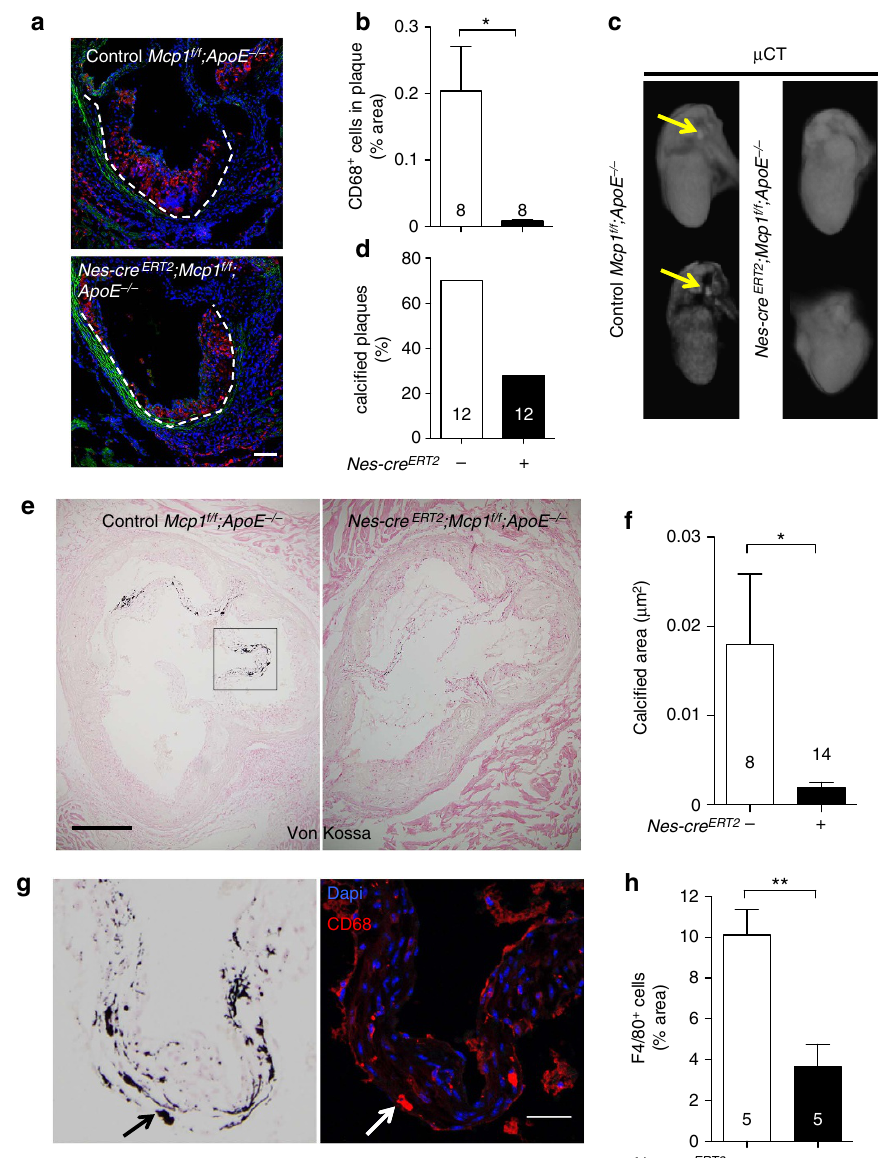
Figure 6 | Mcp1 deletion in nestin þ cells reduces vascular calcification. ( a ) Immunofluorescence of CD68 (red) to label macrophages infiltrated in the valves of Nes-cre ERT2 ;Mcp1 f/f ; ApoE (cid:2) / (cid:2) mice and Mcp1 f/f ; ApoE (cid:2) / (cid:2) controls fed with HFD for 6 weeks. Nuclei were counterstained with DAPI (blue). ( b ) Quantification of CD68 þ cells in the atheroma plaque of these mice ( n ¼ 8). ( c ) Representative ex-vivo microtomography ( m CT) photographs of the hearts of Nes-cre ERT2 ;Mcp1 f/f ; ApoE (cid:2) / (cid:2) mice and Mcp1 f/f ; ApoE (cid:2) / (cid:2) controls. Arrows indicate calcified plaques. ( d ) Frequency of hearts that showed calcified plaques ( n ¼ 12). ( e ) Representative sections of Von Kossa staining of calcium deposits (black) in the aortic valves of these mice. ( f ) Calcified area in three sections from the aortic valves of these mice ( n ¼ 8–14). ( g ) Consecutive aortic valves sections stained with Von Kossa (black) or DAPI (blue) and anti-CD68 antibodies (red). Note the proximity of CD68 þ macrophages to the calcified areas (arrow, example). ( h ) Number of F4/80 þ macrophages (not shown) infiltrated in the aortic leaflets ( n ¼ 5). ( b , d , f , h ) Data are means ± s.e.m.; n and P values are indicated; * P o 0.05, ** P o 0.01, unpaired two-tailed t test. ( a , g ) Scale bars, 100 m m, ( e ) 200 m